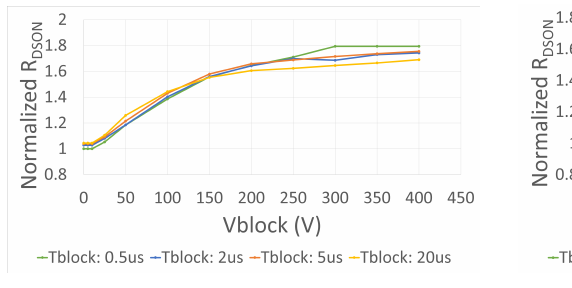
Figure 10. Normalized R ON VS V block evaluated in two distinct time instants ∆ T M . ( a ) R ON at ∆ T M = 20 µ s for different T block ; ( b ) R ON at